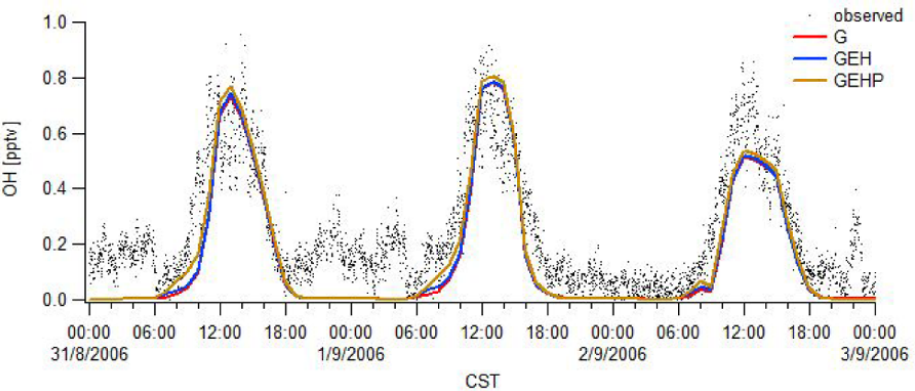
Fig. 4. Time series of observed and simulated OH mixing ratios at the top of the Moody Tower, at 60ma.g.l., which corresponds to the second model